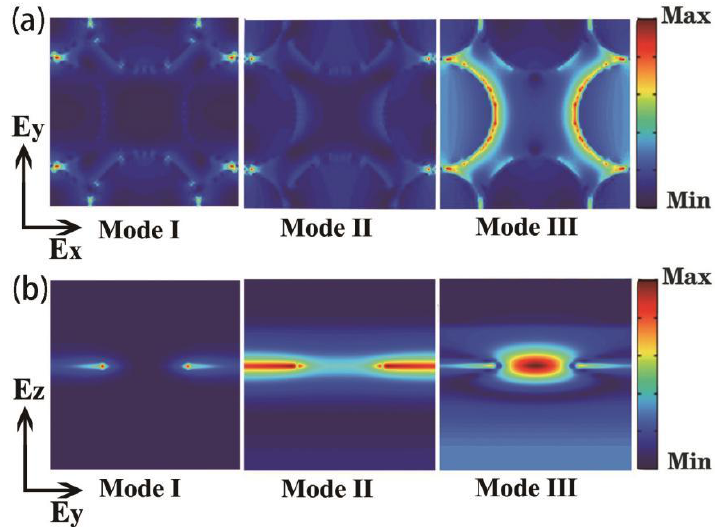
Figure 3. Modes (I)~(III) show the electric field distribution of the x–y plane ( a ) and y–z plane ( b ) of the graphene plasmon absorber at λ 1 = 2.67 μm, λ 2 = 2.87 μm, and λ 3 = 3.68 μm, respectively.